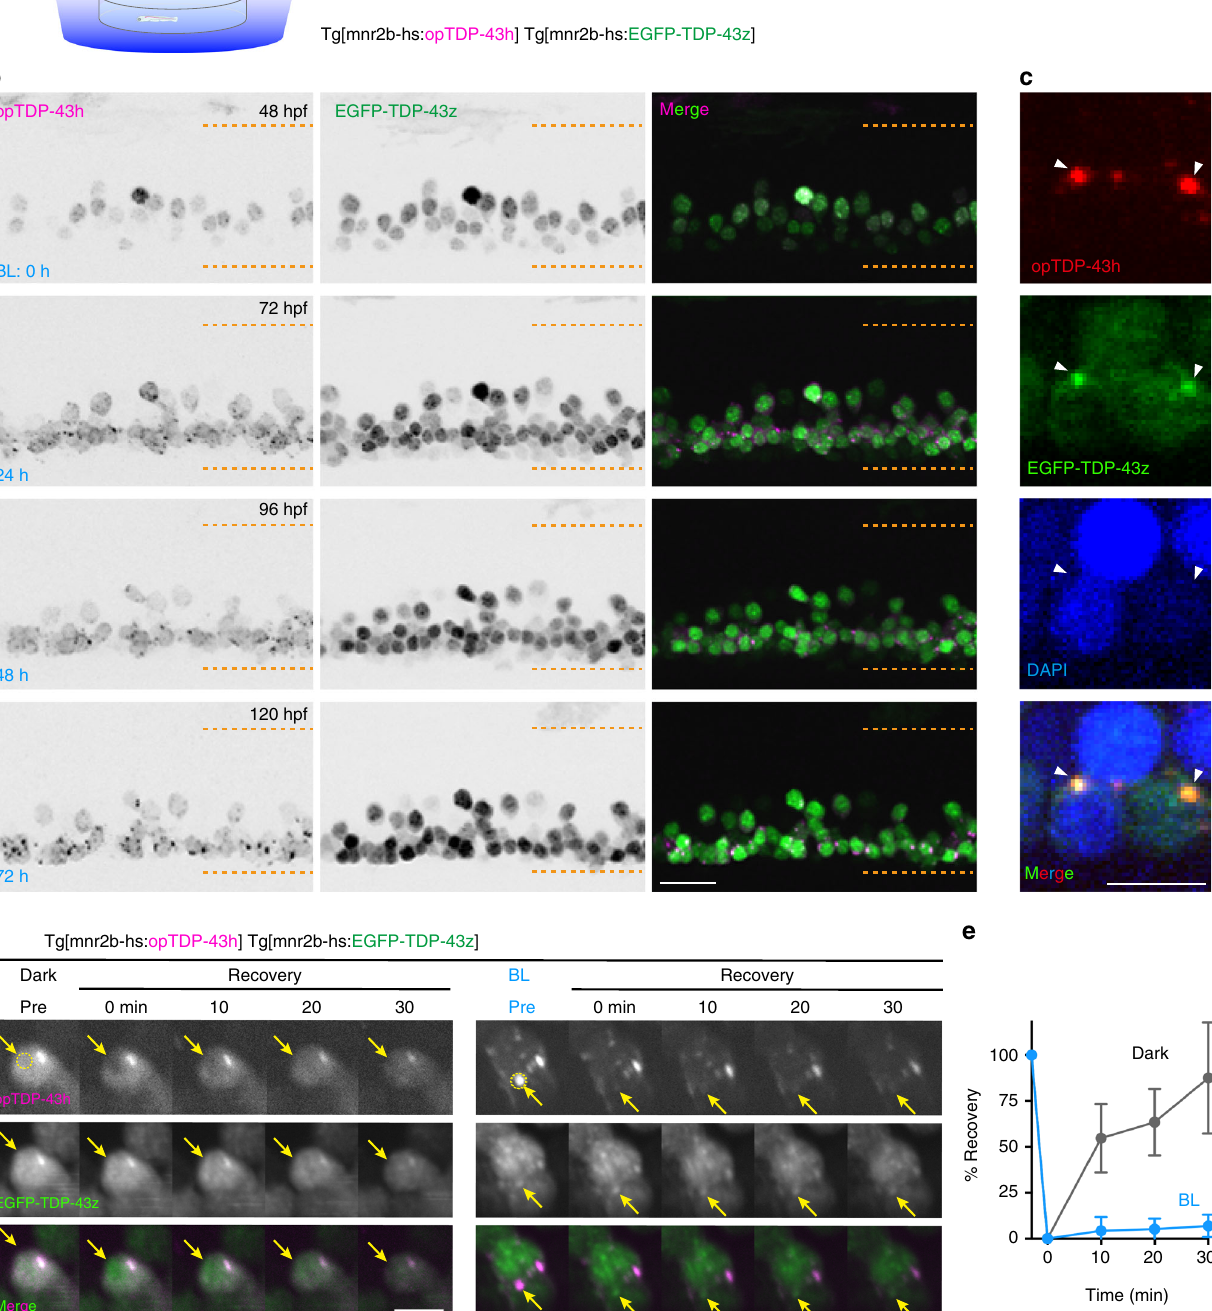
Fig. 6 Long-term illumination induces opTDP-43h aggregation that seeds non-optogenetic TDP-43 aggregation. a Chronic fi eld illumination of unrestrained Tg[mnr2b-hs:EGFP-TDP43z] Tg[mnr2b-hs:opTDP-43h] fi sh by blue LED light. b Live imaging of the spinal motor column from 48 to 120 hpf. Horizontal dashed lines demarcate approximate positions of dorsal and ventral limits of the spinal cord. c Cytoplasmic opTDP-43h foci colocalize with EGFP-TDP-43z. d FRAP analyses of nuclear opTDP43h that had not been exposed to blue light (left, Dark Pre) and cytoplasmic opTDP43h foci that had been induced by a 72-h blue light illumination (right, BL Pre). Bleaching was performed at 120 hpf. Yellow dashed circles (Pre) include photobleached area and arrows indicate the bleached position. e Quanti fi cation of fl uorescent recovery. The results were obtained from 6 cells in independent 6 animals for each condition. Error bars show SD, and the center of the error bars is the average value. The bars indicate 20 µ m ( b ), 5 µ m ( c, d ). Error bars show